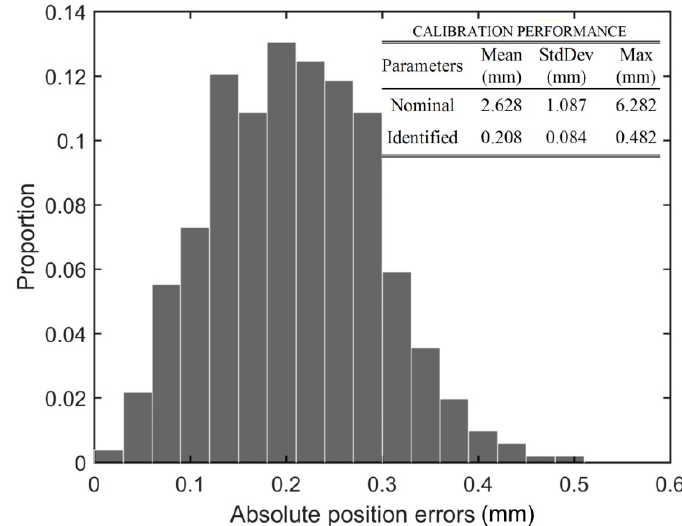
Figure 13. Histogram of absolute position errors at the TCP after calibration.